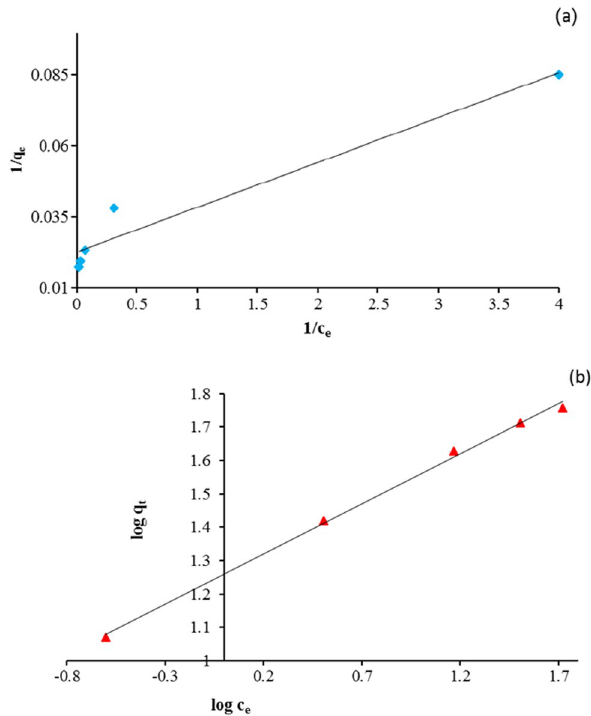
Fig. 8 Langmuir ( a ) and Freundlich ( b ) isotherm model in DZN adsorption using AC–ZnO